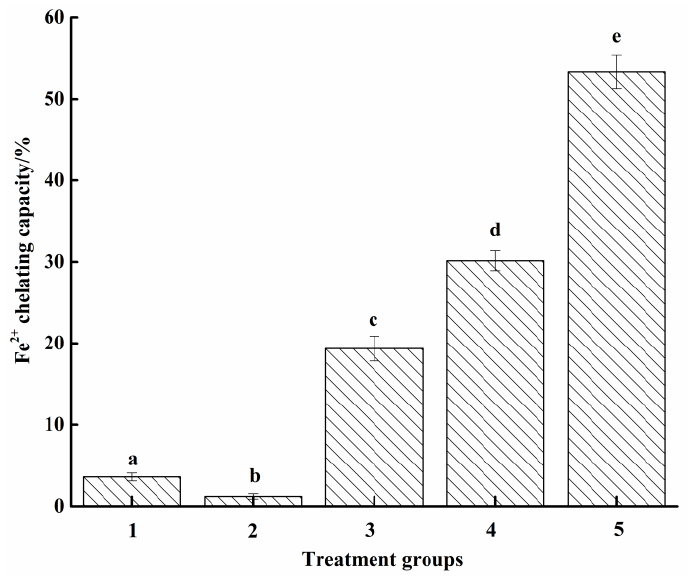
Figure 5. Chelating ability of Fe 2+ . Groups 1 to 4 were the same as above. Group 5: EDTA solution (0.2 mg/mL). Different letters between groups represent significant differences ( p < 0.05).